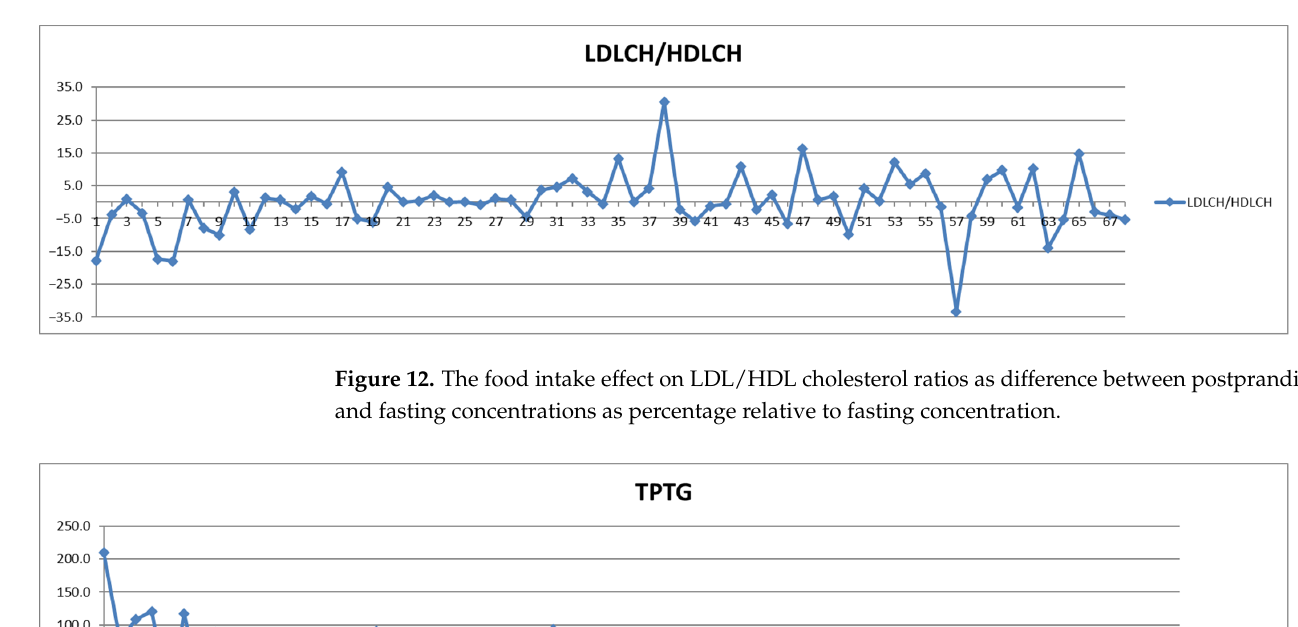
prandial (red) status for control cases (1–29) and CVD cases (30–68).